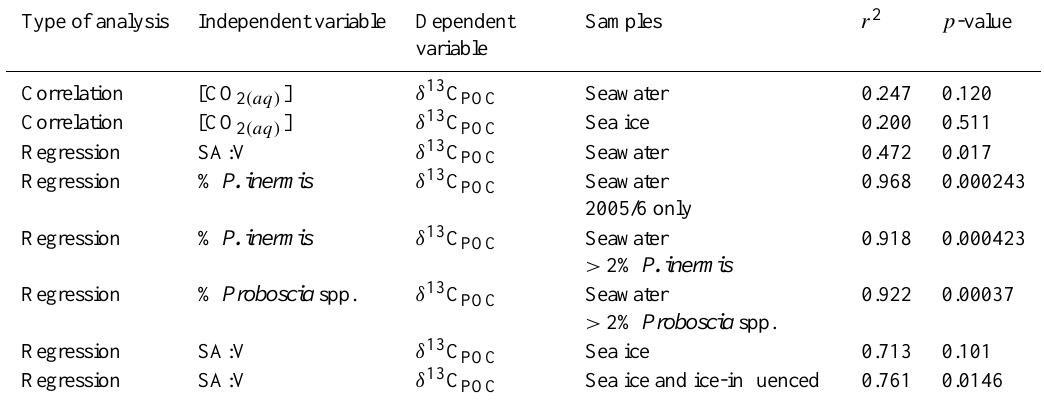
Table A1. Type, input terms and results of statistical analyses performed using R computing software. All regressions are least-squares linear regressions and r 2 values are given as the adjusted r 2